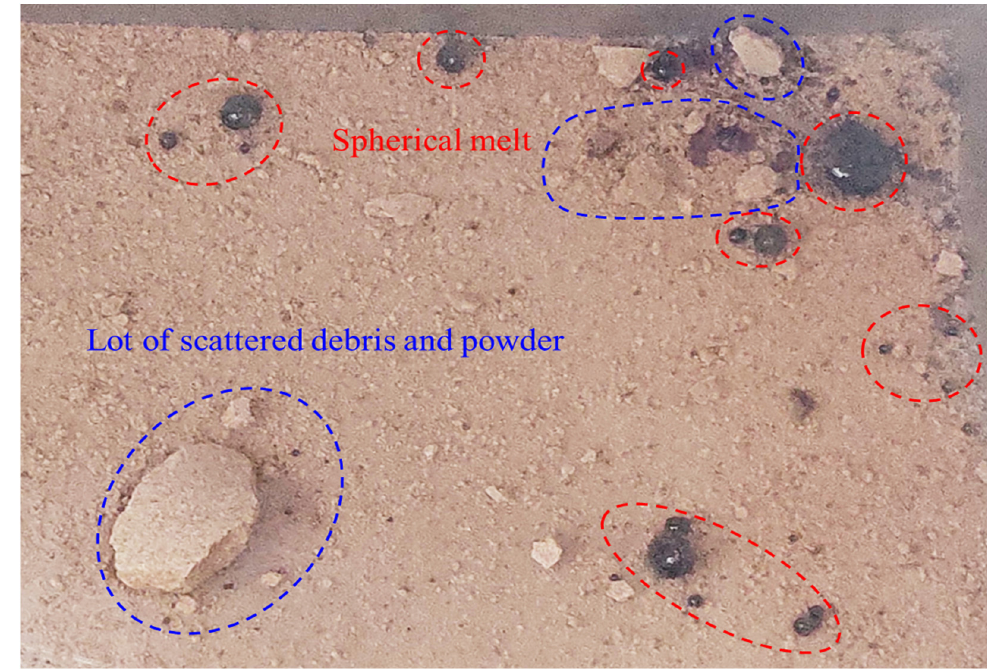
Figure 11. Scattered red sandstone fragments and spherical glassy melts.